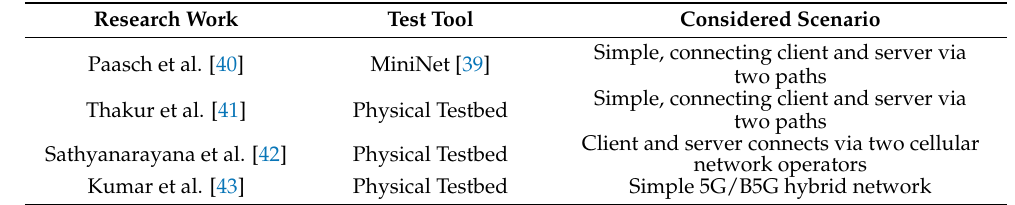
Table 1. A brief overview of the existing research works on the performance analysis of the MPTCP